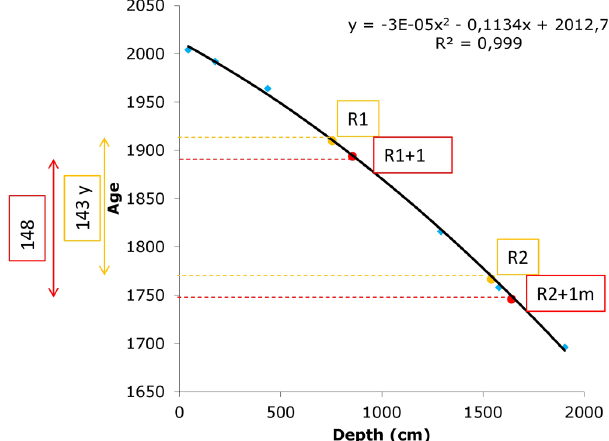
Fig. 5. 2009 Depth–age relationship at DC (black curve) based on dating of EPICA Dome C volcanic layers (blue dots). The age in- terval between reflectors R1 and R2 is shown, as well as the age interval between those two reflectors if a 1m-shift in depth is ap-